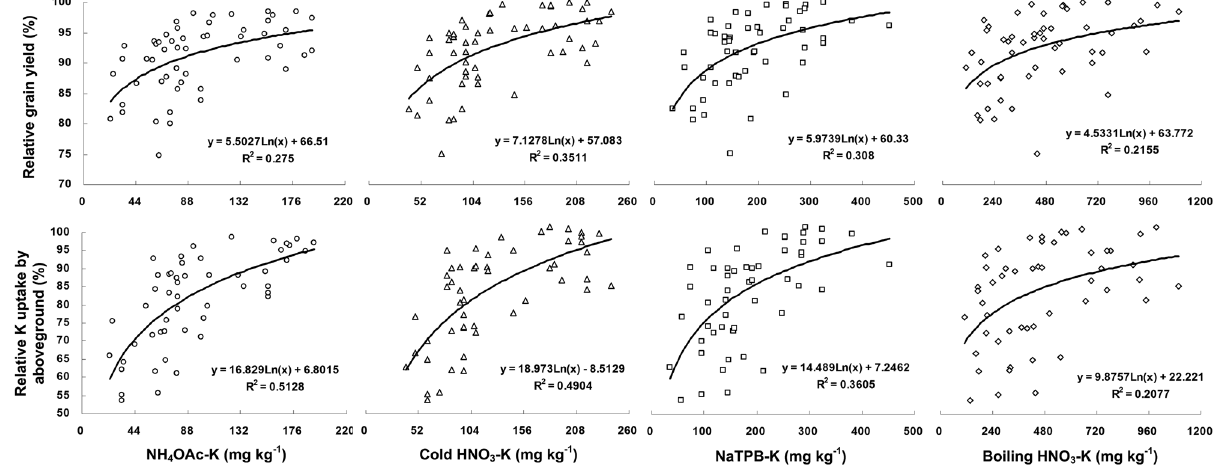
Figure 4. Relationships between K extracted from non-fertilized samples and rice relative grain yield, relative K uptakes response to K fertilization. Lines represent the fit of a logarithm model.